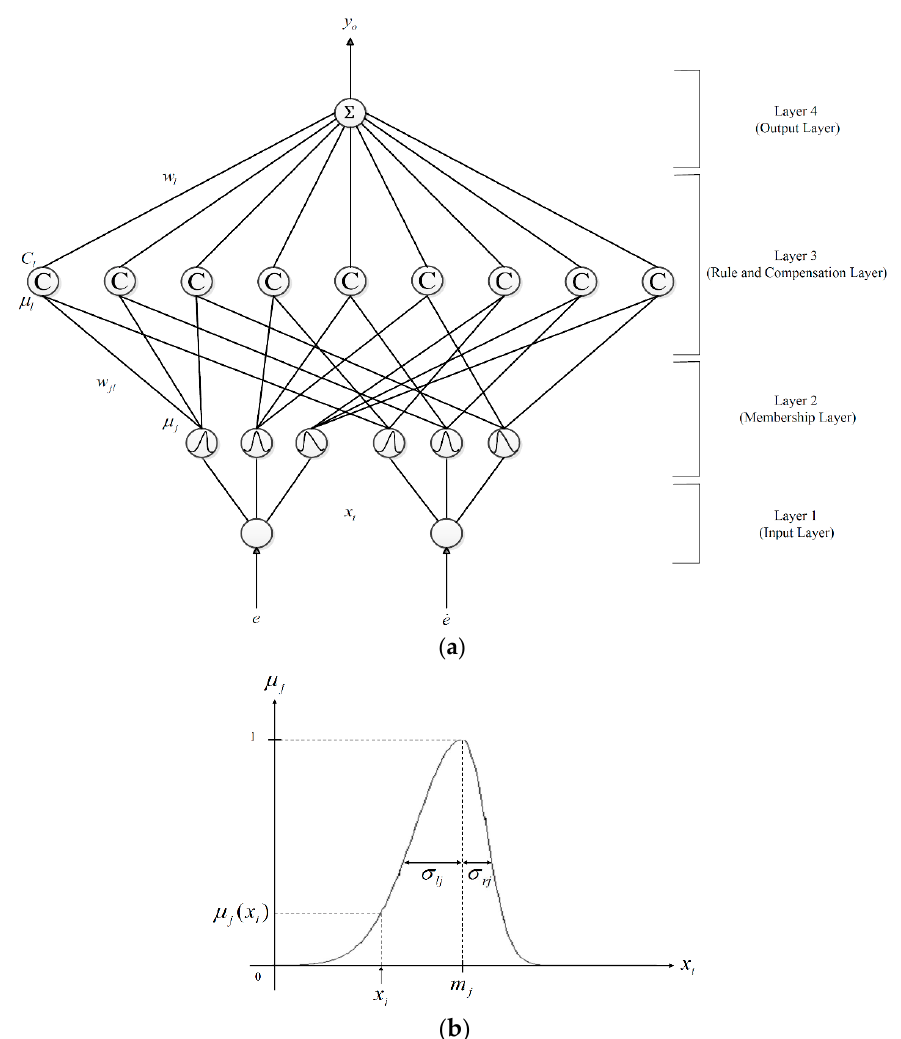
Figure 3. Network architecture of CFNN-AMF: ( a ) Network architecture; ( b ) Asymmetric Gaussian function.